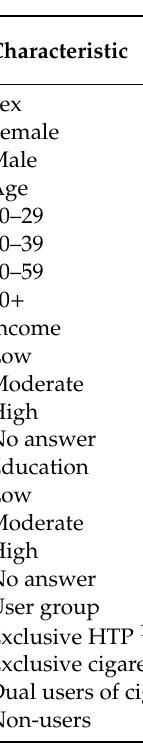
Unweighted Frequency (%) ( n =